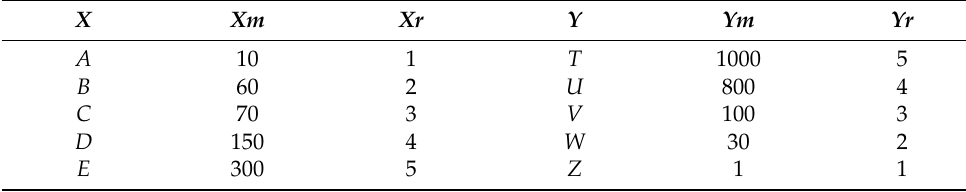
Table 1. Initial data (columns X and Y —names of quantities, Xm and Ym —values of quantities on a metric scale; Xr and Yr —ranks or values of quantities on an ordinal